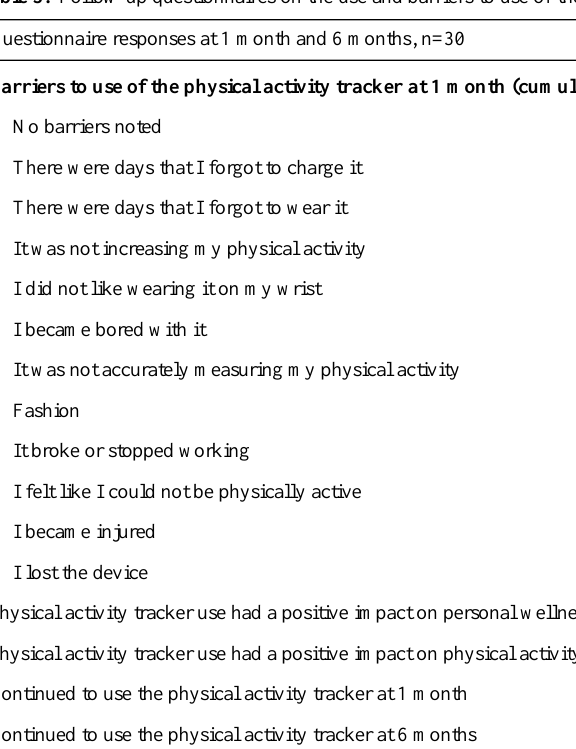
n (%)Questionnaire responses at 1 month and 6 months, n=30 15 (50)No barriers